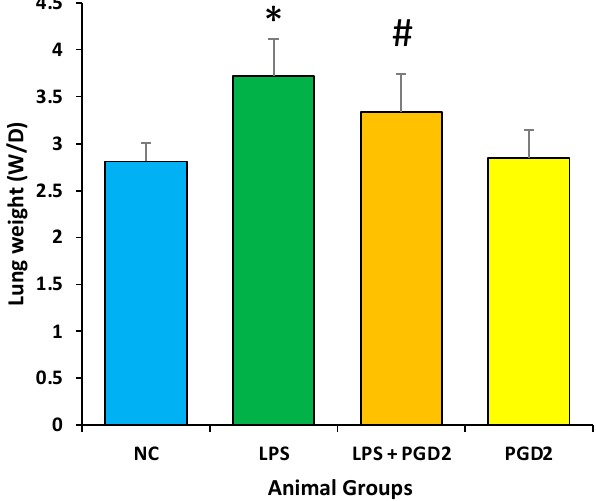
Figure 3. W/D ratios of lungs in various groups of animals. The values denote mean ± SEM, with 8 animals in each group. The statistically significant difference ( p < 0.05) is illustrated by asterisk (*) between the NC and LPG groups and with (#) between the NC and LPS + PGD 2 groups.